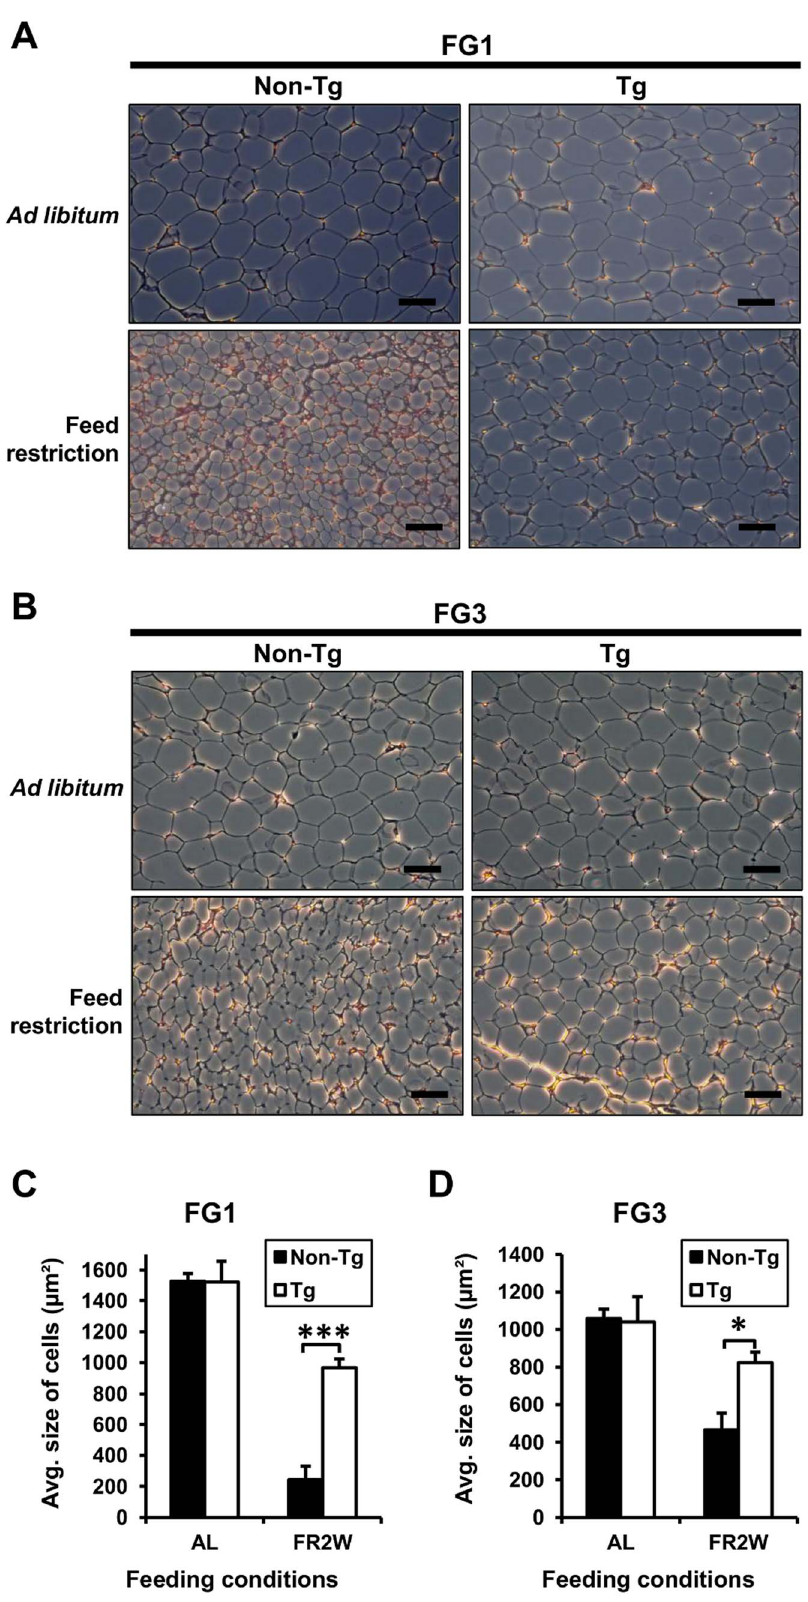
Figure 4. Comparison of fat cell size under the different feeding conditions. (A and B) Histology of fat tissues from transgenic and non- transgenic quail of FG1 and FG3. Fat cell size was almost the same between transgenic and non-transgenic quail in both lines fed ad libitum , while it shrank to different levels between them after feed restriction. All scale bars: 50 m m. (C and D) Numerical data of average fat cell size in different